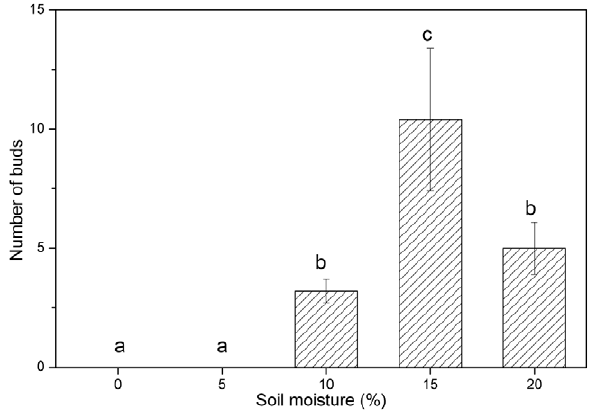
Figure 4. Number of buds on root sections buried in soil at different moisture contents. Values with the same letter are